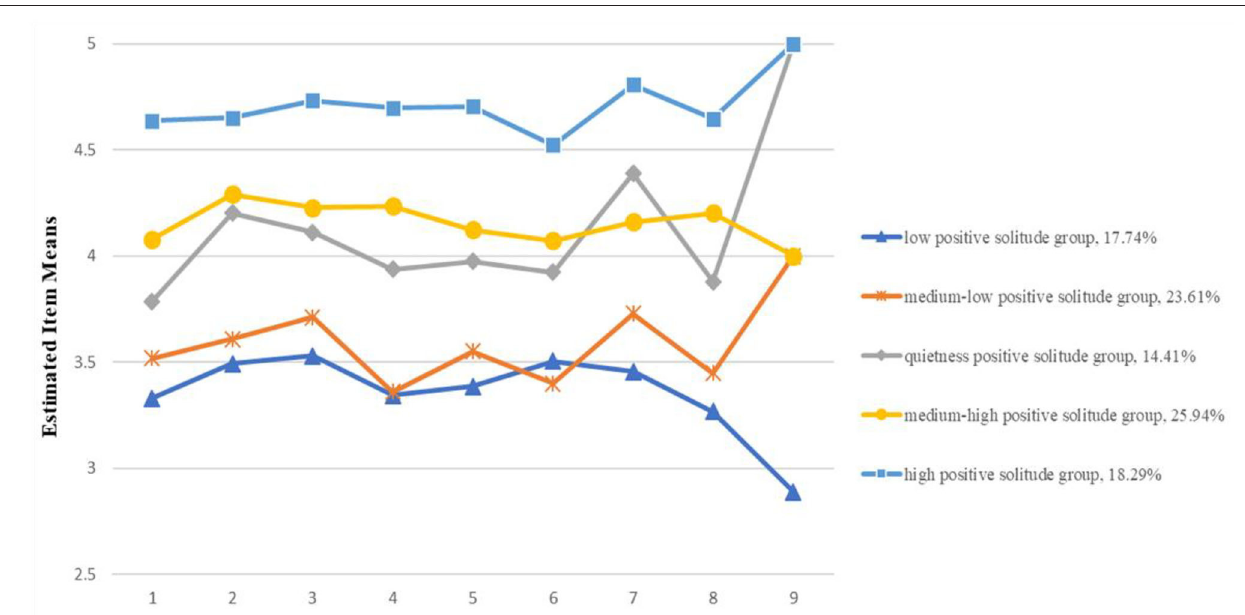
FIGURE 1 | The five profiles of positive solitude by latent profile